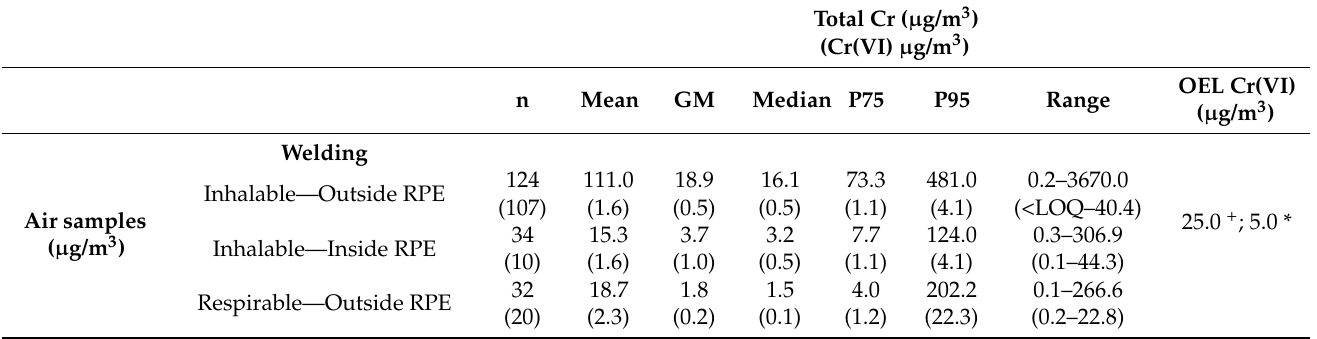
Table 2. Levels of total Cr and Cr(VI) in industrial hygiene samples (air and hand wipe